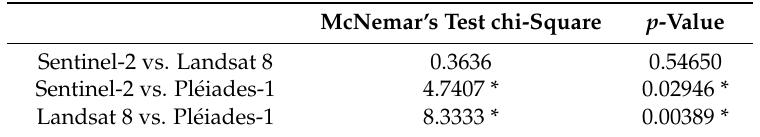
Table 9. Statistically significant comparison between Landsat 8, Sentinel-2, and Pl é iades-1 in mapping mangrove